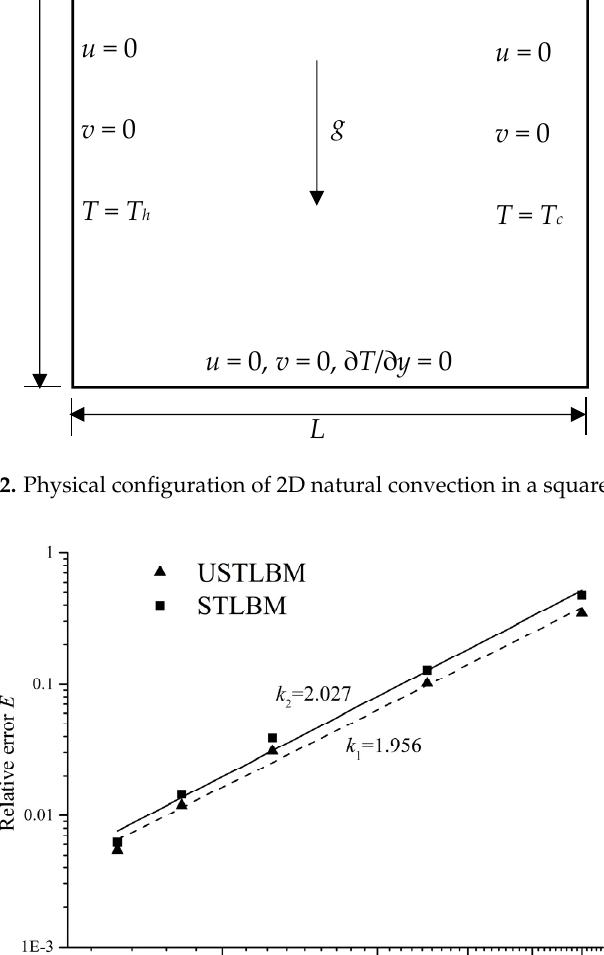
Table 1. Comparisons of flow parameters in Ra = 10 5 at different mesh sizes. Parameters